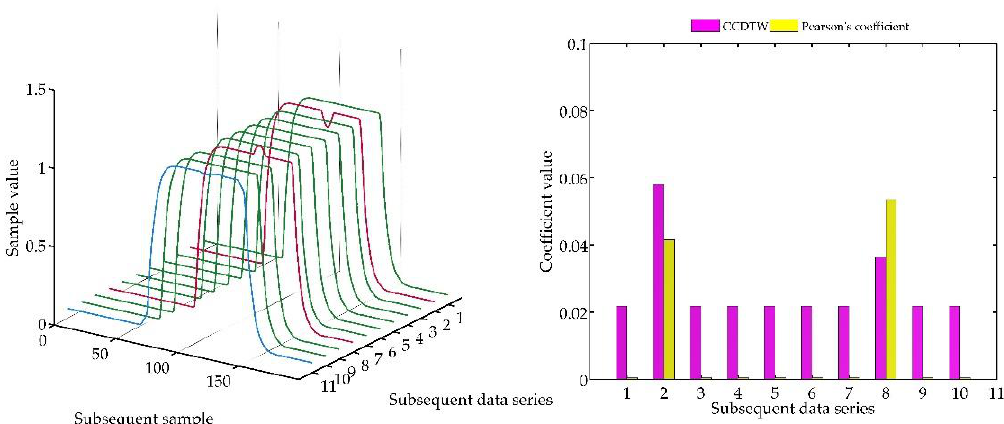
Figure 24. Simulation results obtained for disturbed and shifted charts № 2 and № 8 for r ampl = 1.